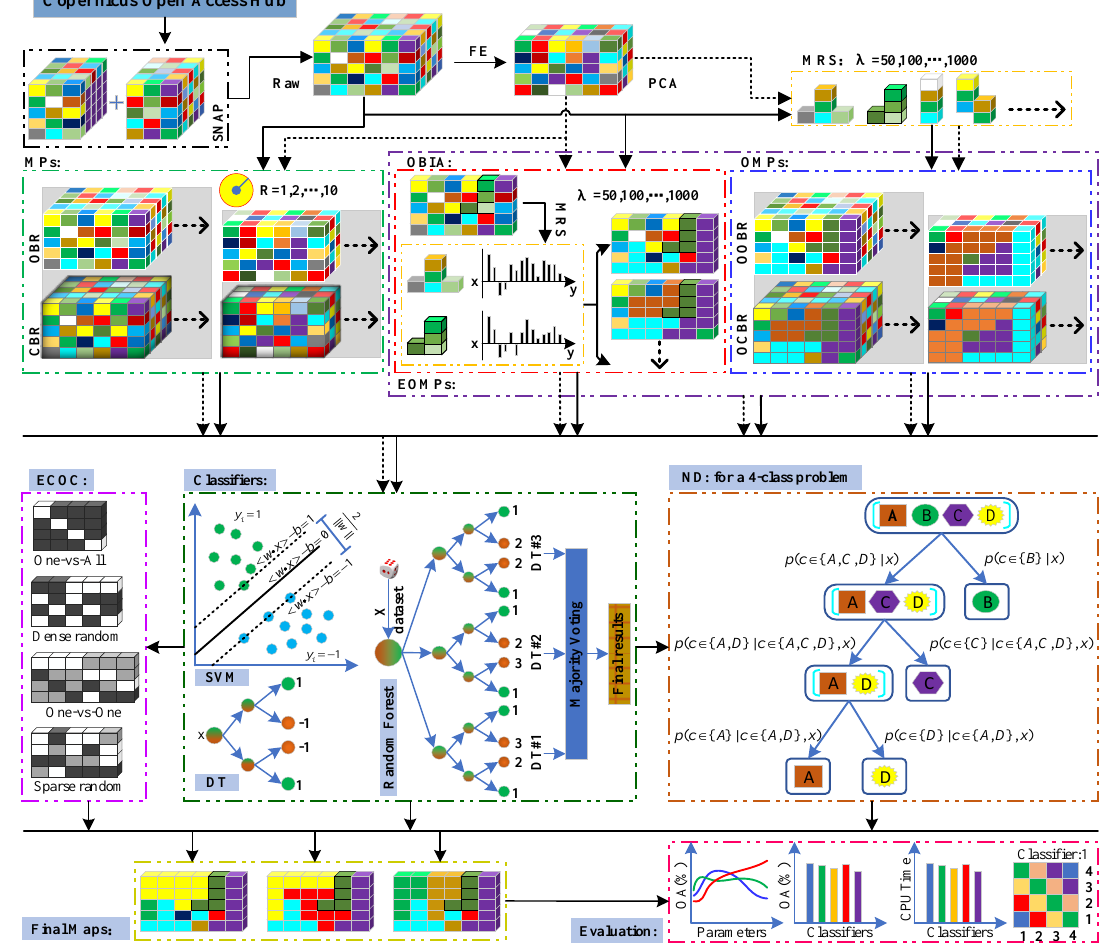
Figure 3. Overall technical flowchart for the methodology.